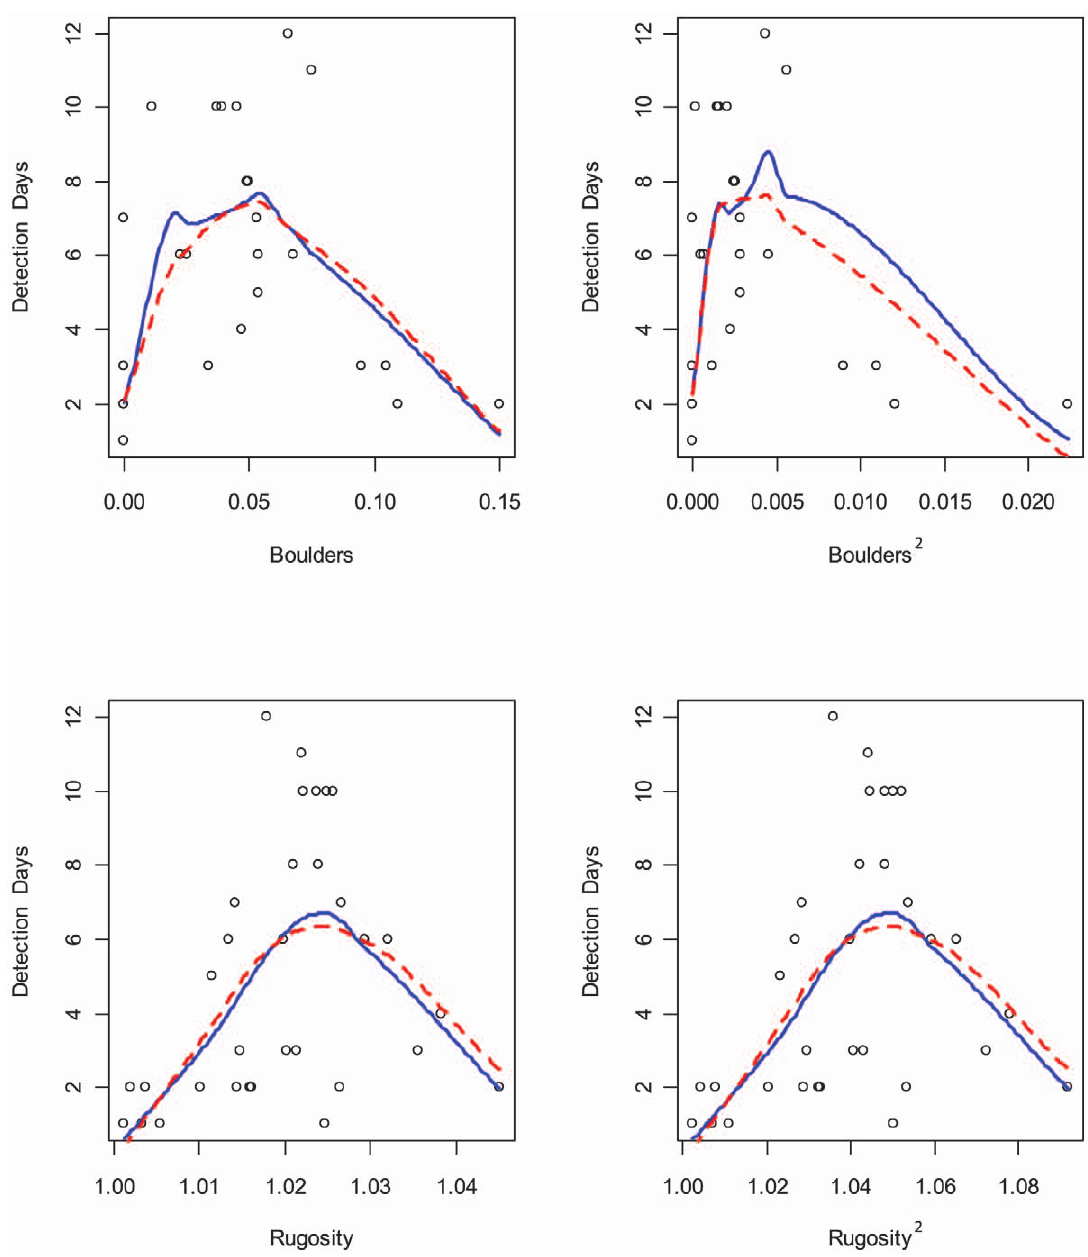
Figure 4. Marginal Model Plots. Four marginal model plots for green sturgeon detection data showing the response variable (Detection-Days) on the vertical axes and the horizontal axes denote numeric predictor values (plotted points) in the final GLM model. Margin model plots provide a graphical representation of model fit by showing the marginal relationships between the response and each predictor. We fitted a regression function for each of the plots using a lowess smooth function for the data (solid blue line) and for the fitted values (dashed red